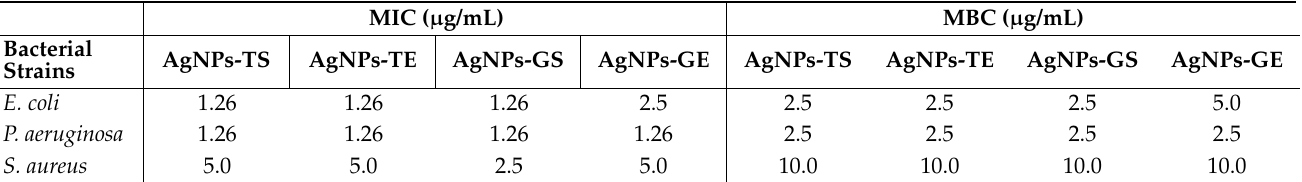
Table 3. Minimum inhibitory concentration (MIC) and minimum bactericidal concentration (MBC) of AgNPs synthesized with the supernatants and extracts of T. harzianum and G. sessile . MIC ( µ g/mL) MBC ( µ